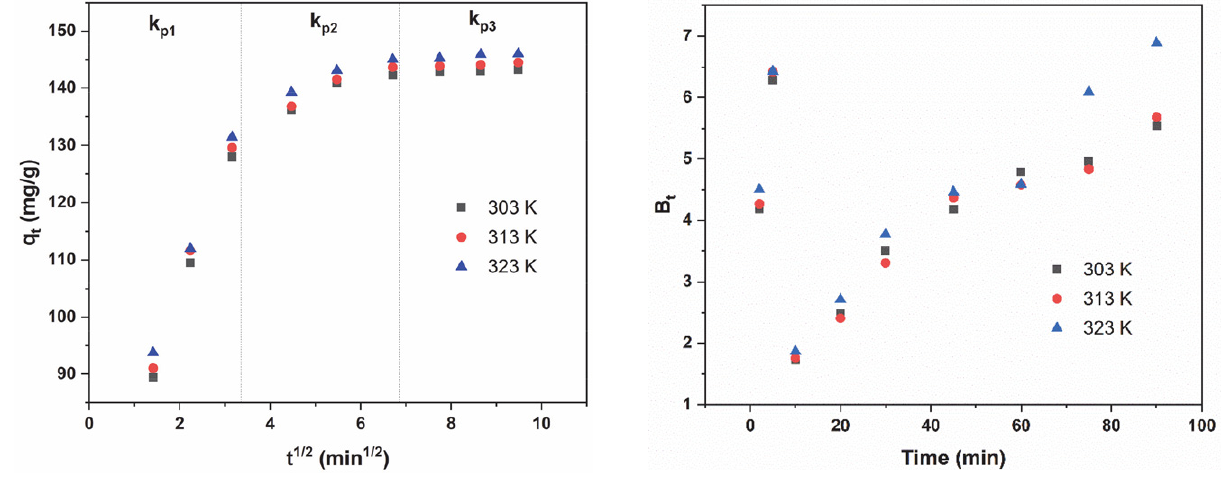
Fig. 7. Boyd plots for MB adsorption by SA-RPB at 303, 313, and 323 K